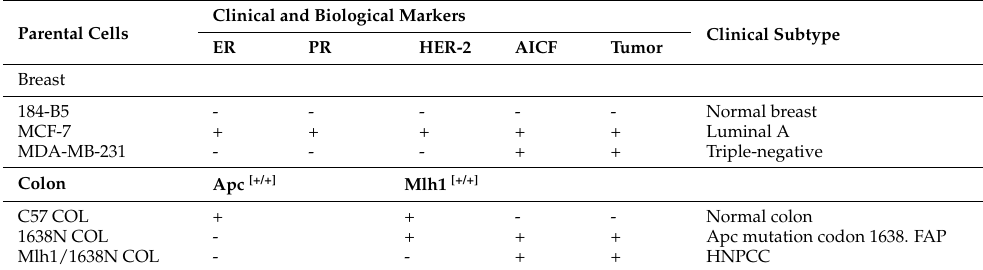
Table 1. Cellular models for breast and colon cancer.